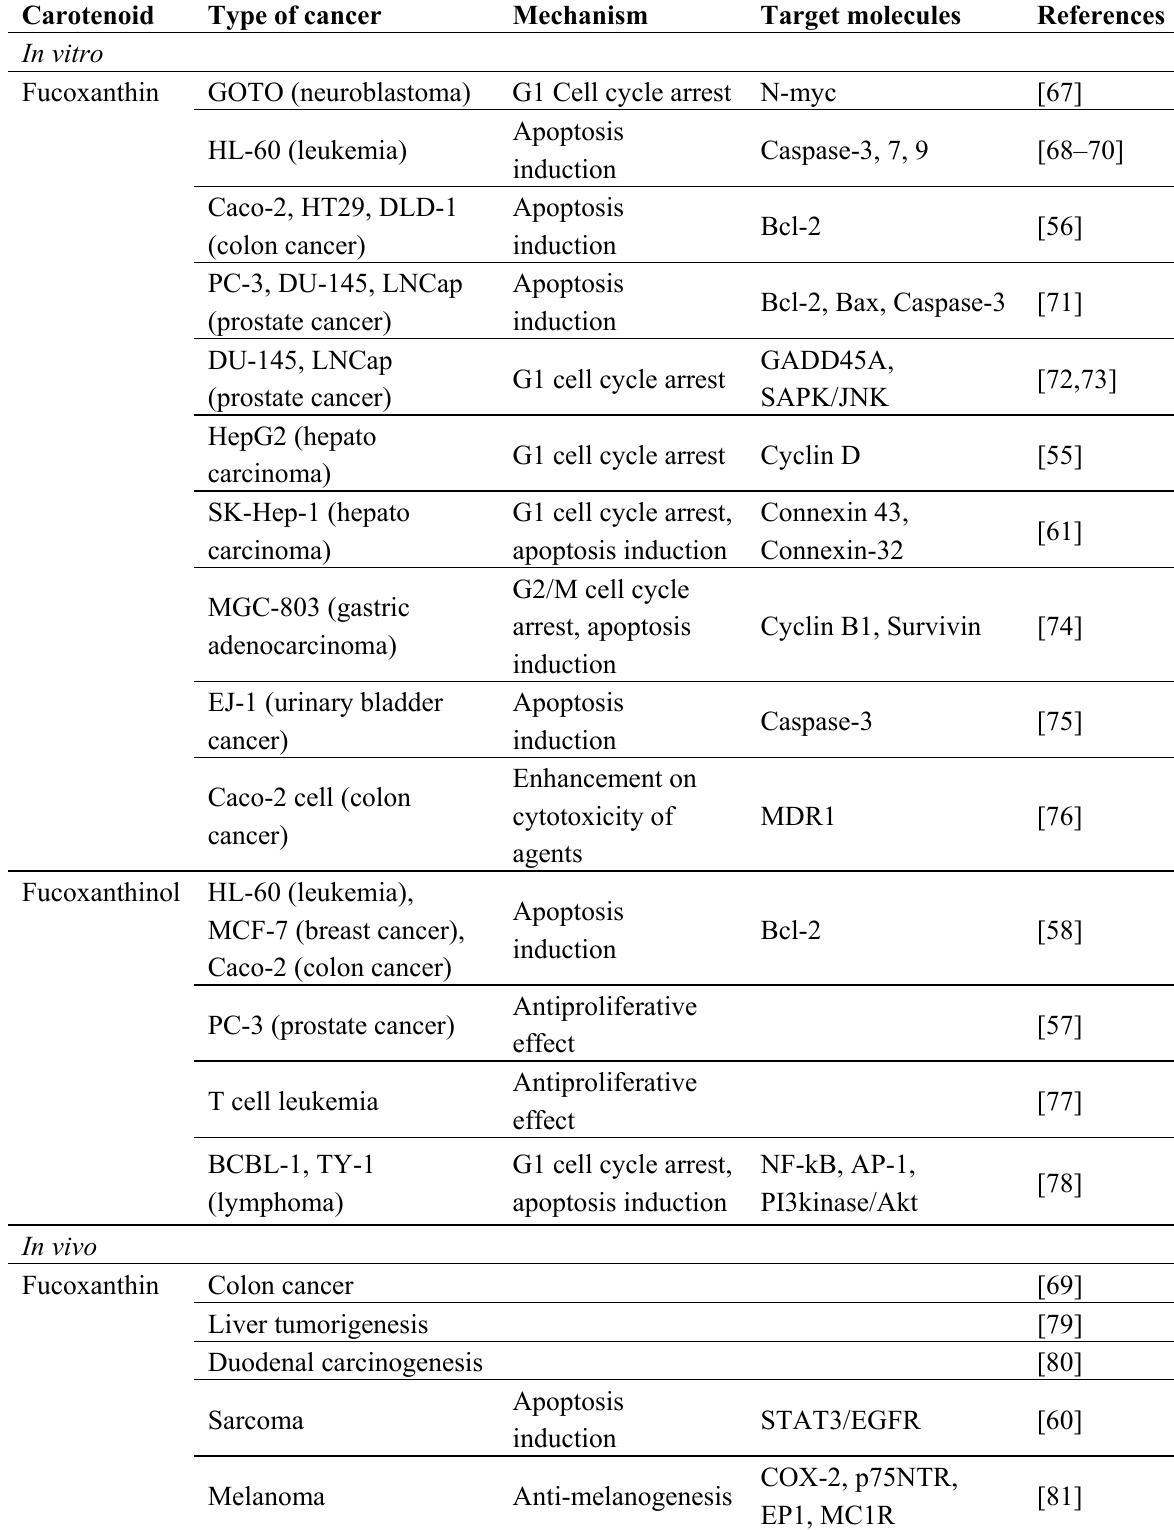
Table 2. Anti-cancer effects of fucoxanthin and fucoxanthinol.